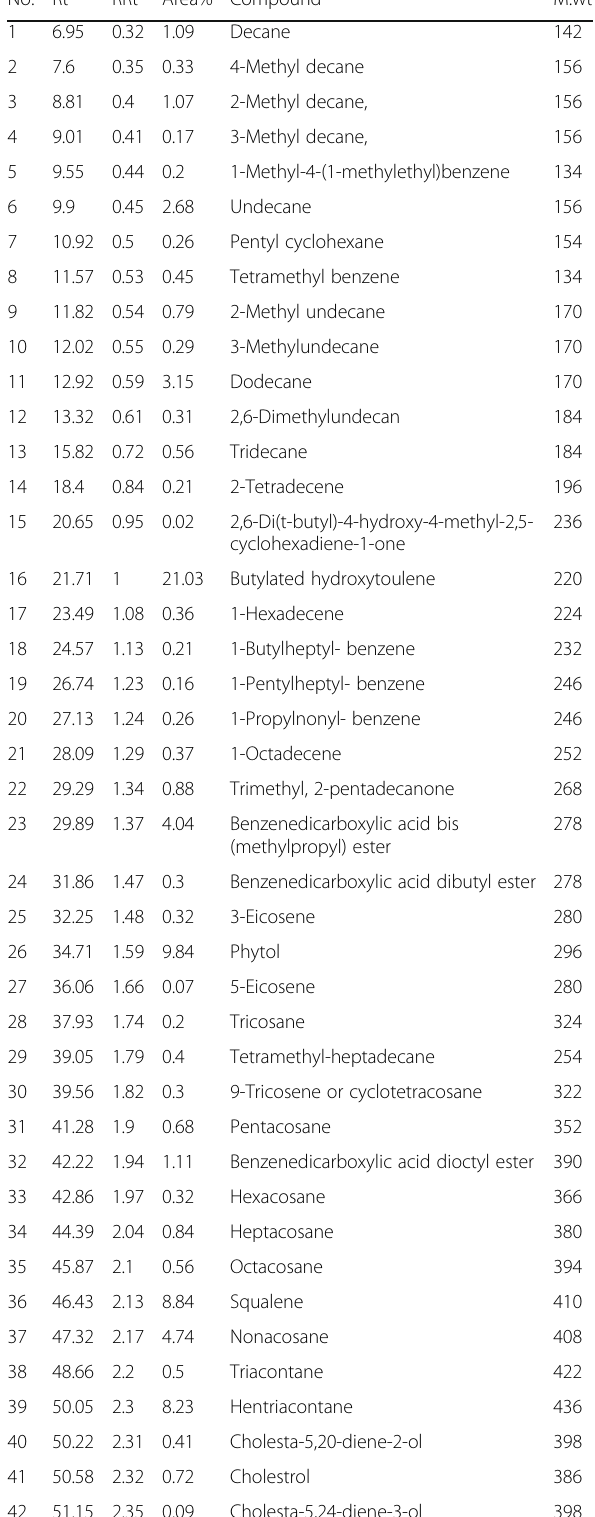
Table 7 GC/MS analysis of unsaponifiable matter of Thevetia peruviana leaves